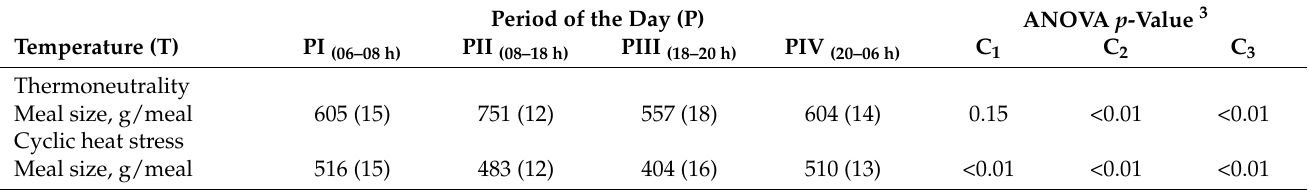
Table 4. Meal size of finishing pigs exposed to thermoneutrality conditions or cyclic heat stress conditions, according to the period of the day 1,2